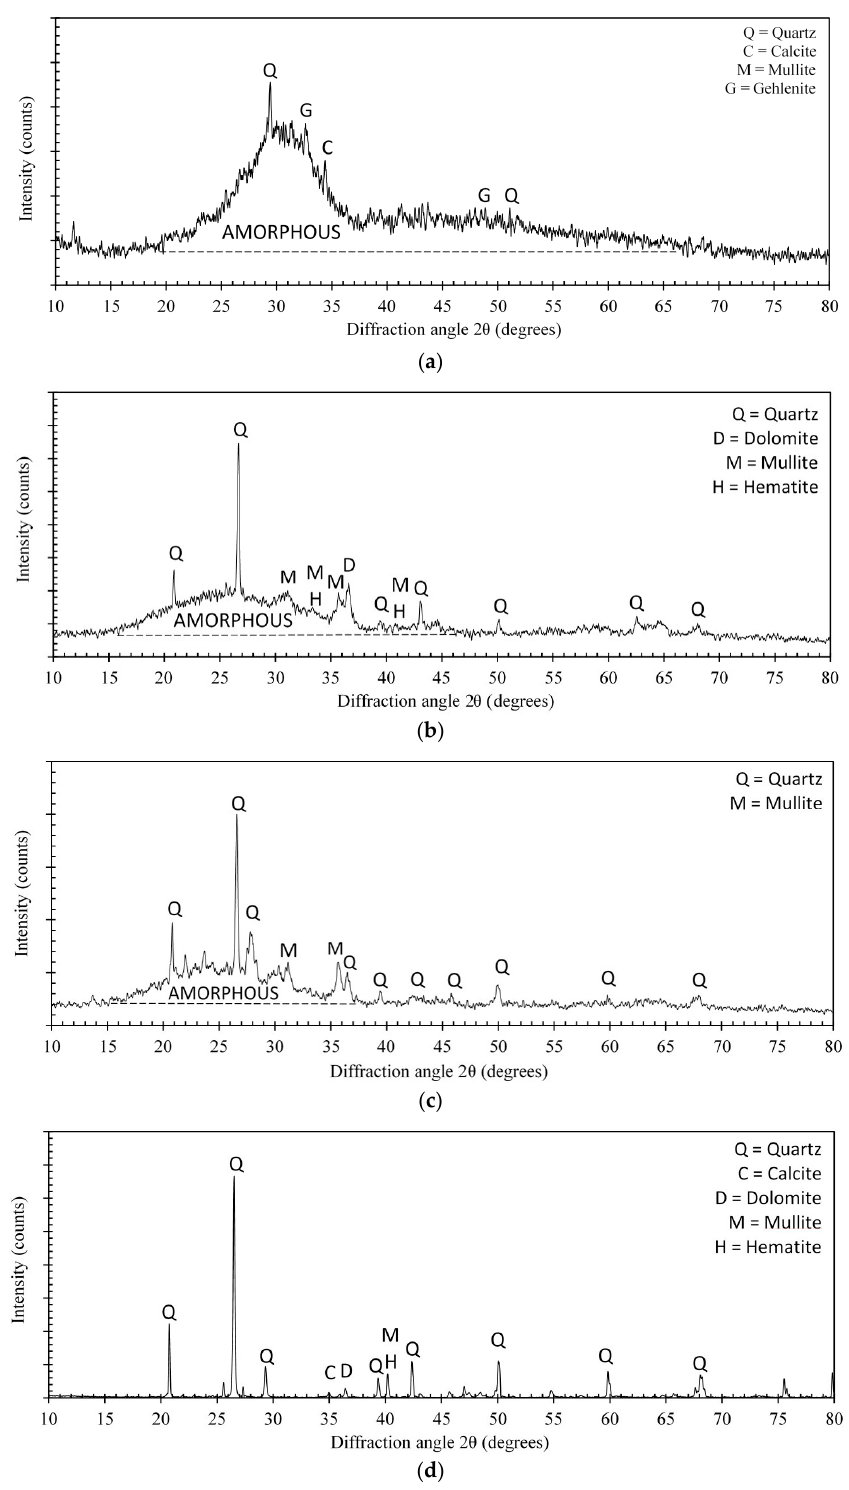
Figure 7. X-ray diffractograms of ( a ) GGBS; ( b ) FA; ( c ) LECA; and ( d ) DS.